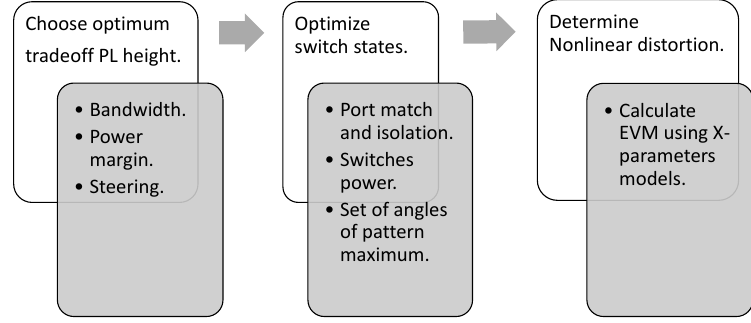
Figure 10. Flow chart with the main elements of the design